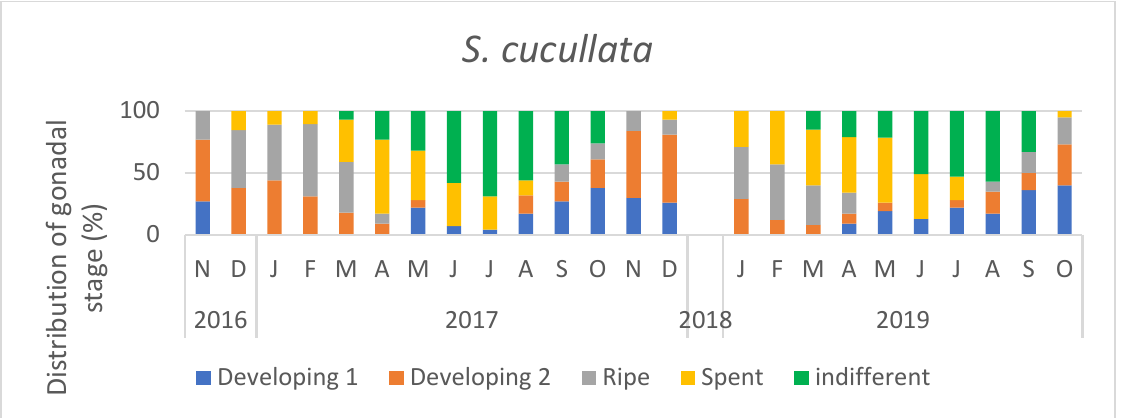
Figure 6. Monthly frequency distribution of gonadal development stages (males and females com- bined) of Pinctada capensis in Inhaca Island.